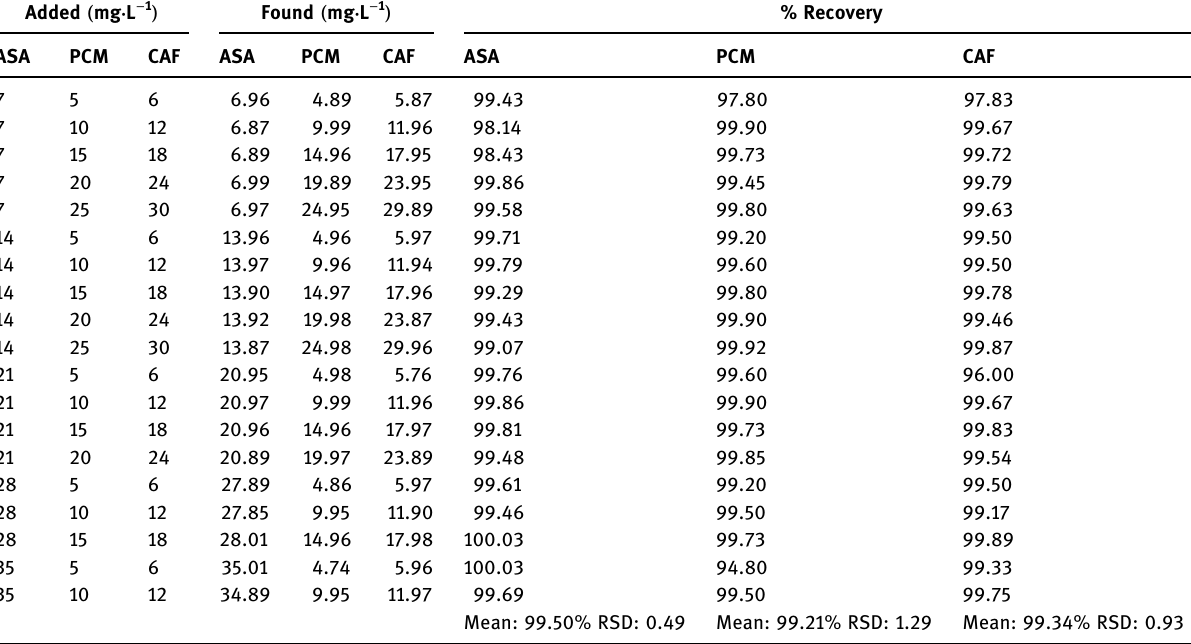
Table 3: For the PLS approach, the composition of the prediction set and the recovery outcomes obtained in synthetic mixtures Added ( mg · L − 1